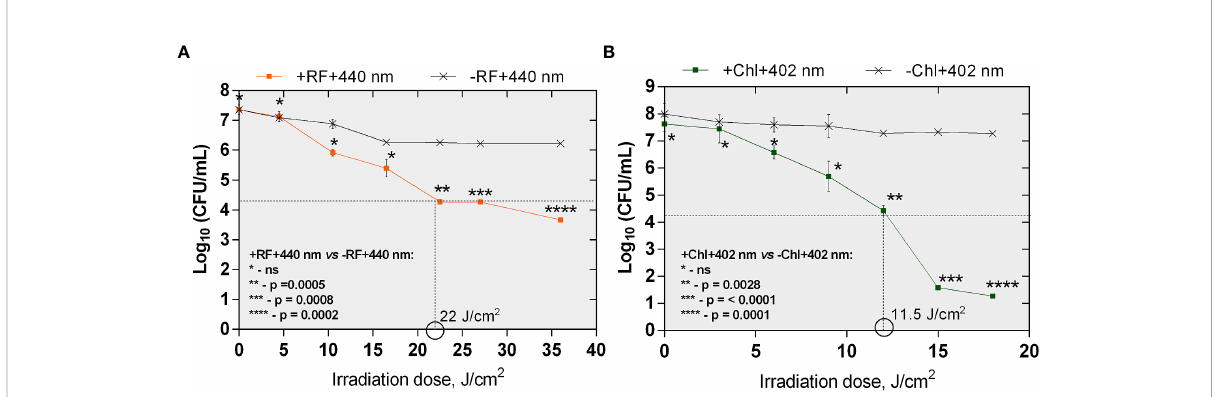
FIGURE 4 The effect of RF-API (A) and Chl-API (B) on Brevundimonas sp. ESA1 free- fl oating (planktonic) cells. Horizontal and vertical dashed lines shown in the graphs indicate the minimal irradiation doses thet were required to achieve a 3 log 10 reduction of CFU counts of the planktonic cells. +RF +440 nm: irradiated using RF, -RF +440 nm: irradiated not using RF, +Chl +402 nm: irradiated using Chl, -Chl +402 nm: irradiated not using Chl; ns – non-signi fi cant. Error bars of some points are too small to be